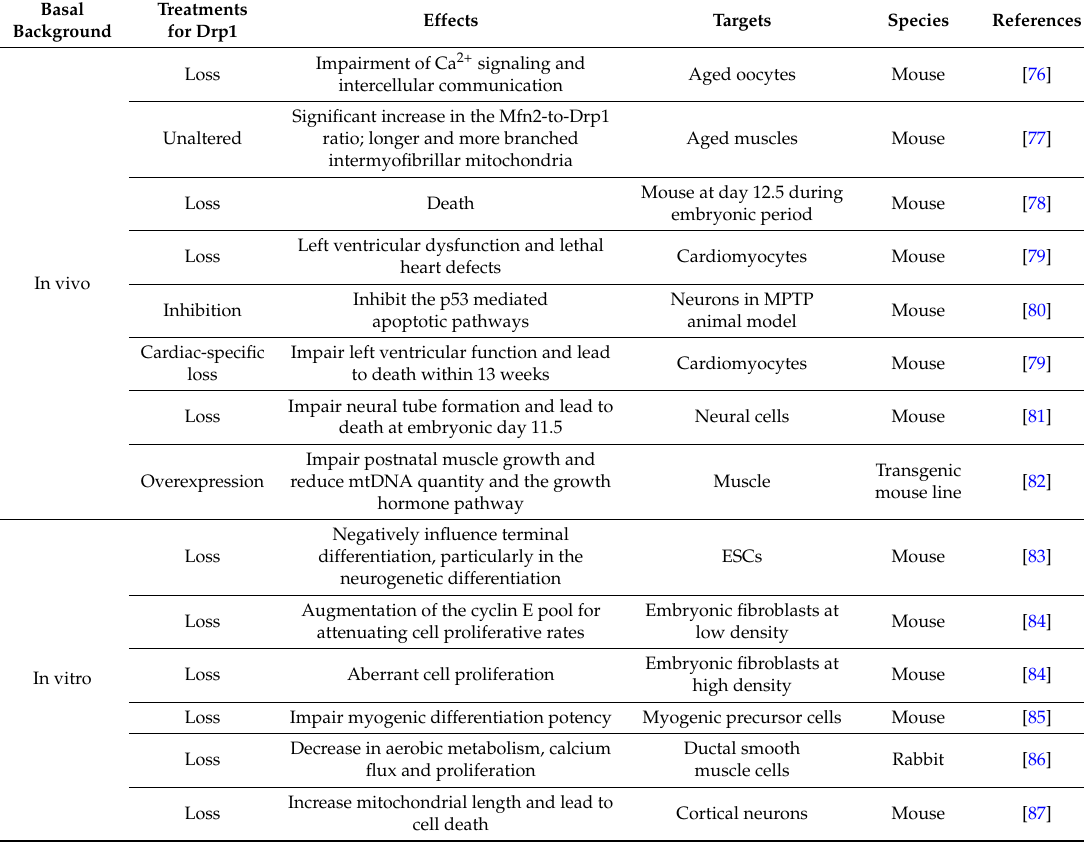
Table 2. Drp1-dependent mitochondrial fission and development in vivo and in